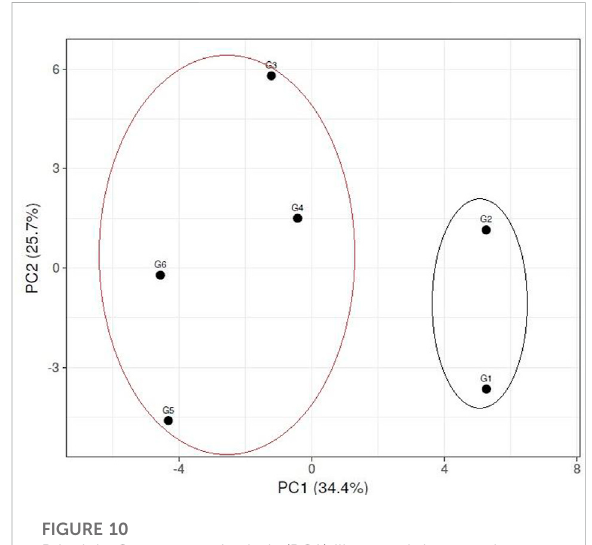
FIGURE 10 Principle Component Analysis (PCA) illustrated the genetic diversity between six sesame genotypes using molecular and cytological data. (G1) Ahs-670, (G2) As-1236, (G3) Bah-697, (G4) Jiz-511, (G5) Jiz-517 and (G6)